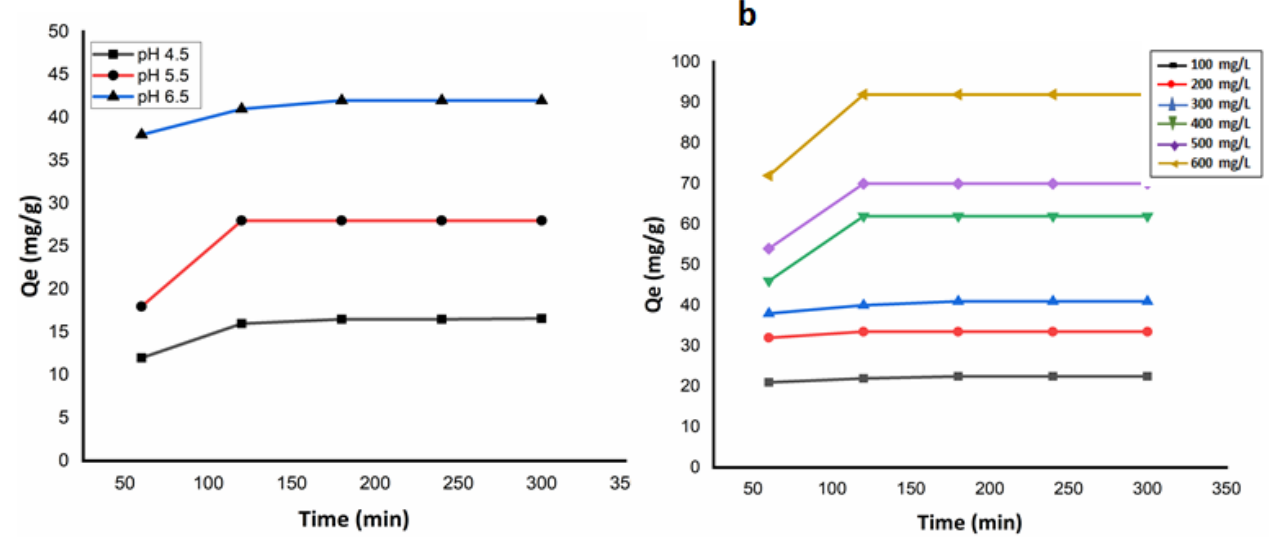
Figure 11. Effect of pH ( a ) and initial concentration of adsorbate ( b ) on the adsorption of TNT wastewater over the applied Fe 3 O 4 NHS as an adsorbent.